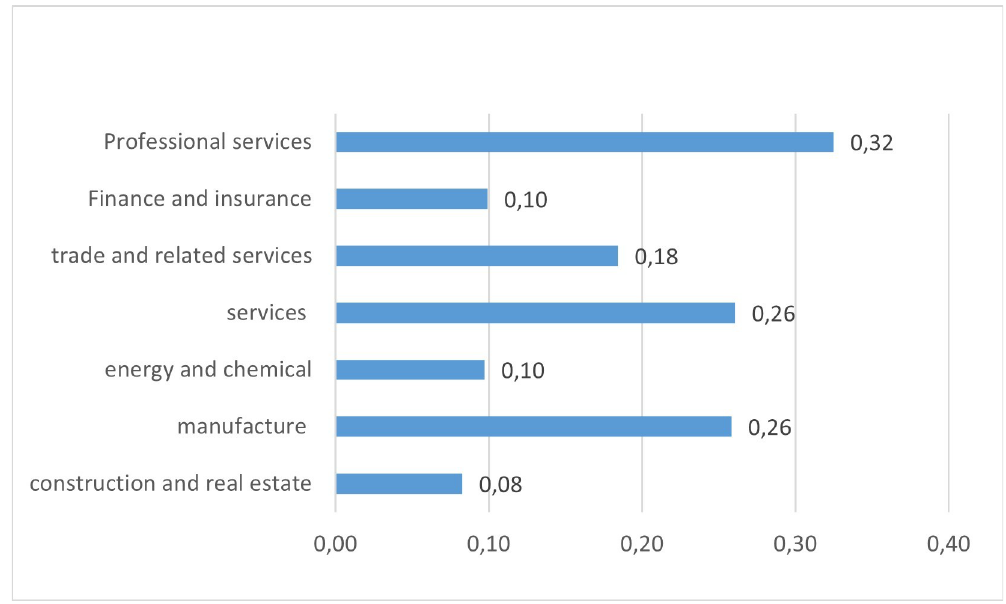
Fig 3. Percentage of intellectual capital stock on total assets by